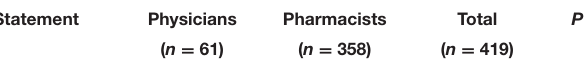
TABLE 5 | Information about the respondent’s attitude toward gene